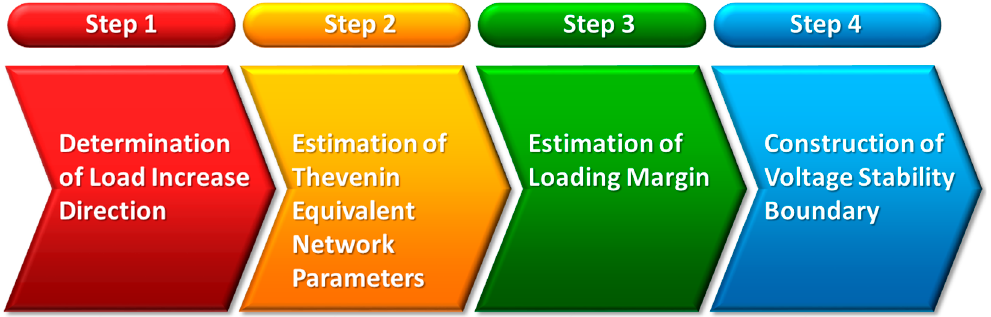
Figure 4. Main steps in the proposed algorithm for voltage stability visualization and monitoring.